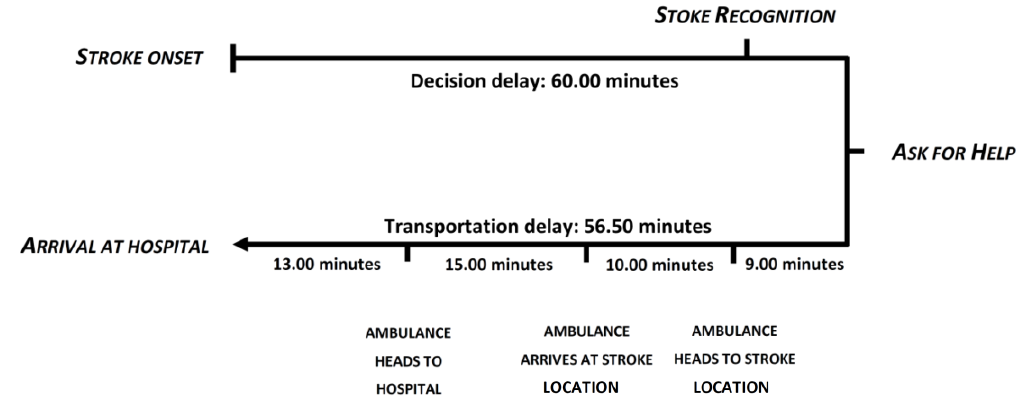
Figure 1. Time to arrival at the hospital segregated by landmarks.